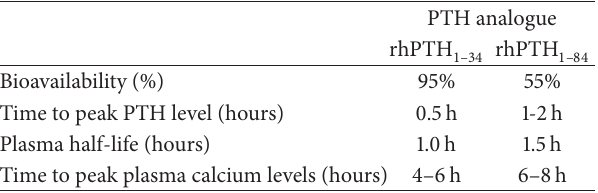
are derived from EMEA online (http://www.ema.europa.eu/ema/). EMA Preotact product description and EMA Forsteo product